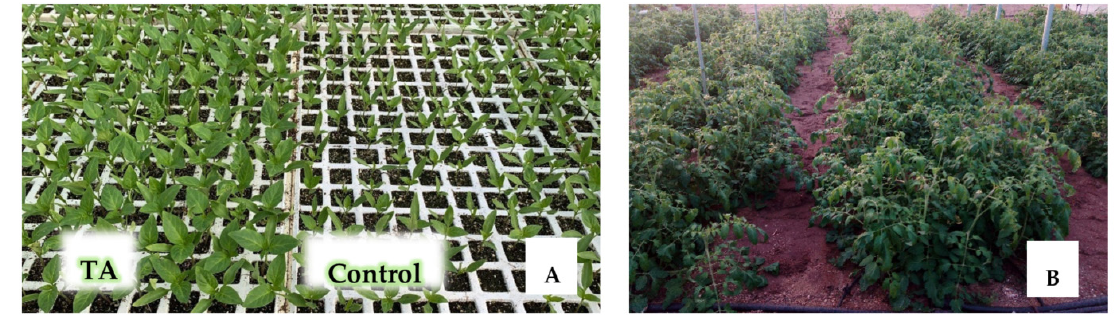
Figure 3. ( A ) Differential growth of pepper seedlings with T. aggressivum f. europaeum (TA), compared to control. ( B ) Tomato plants grown under field transplantation conditions (60 days).